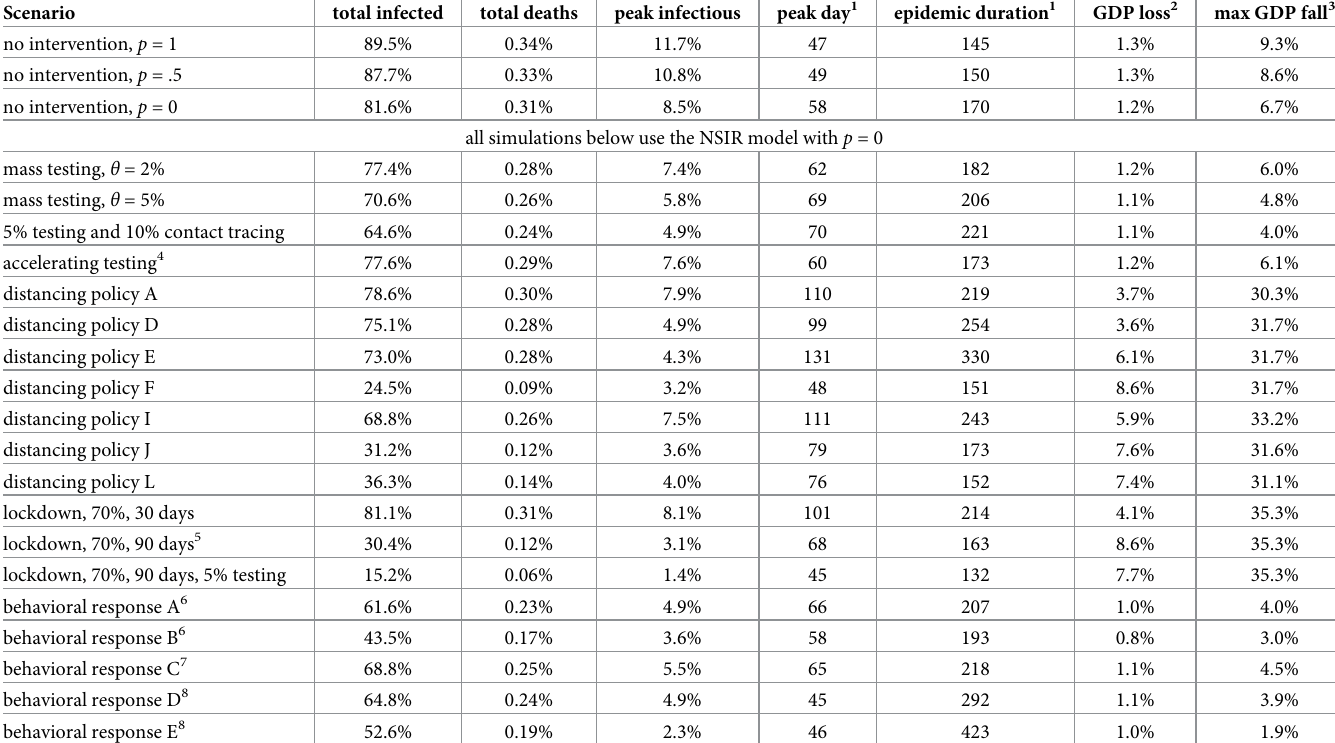
Table 3. Summary of simulation